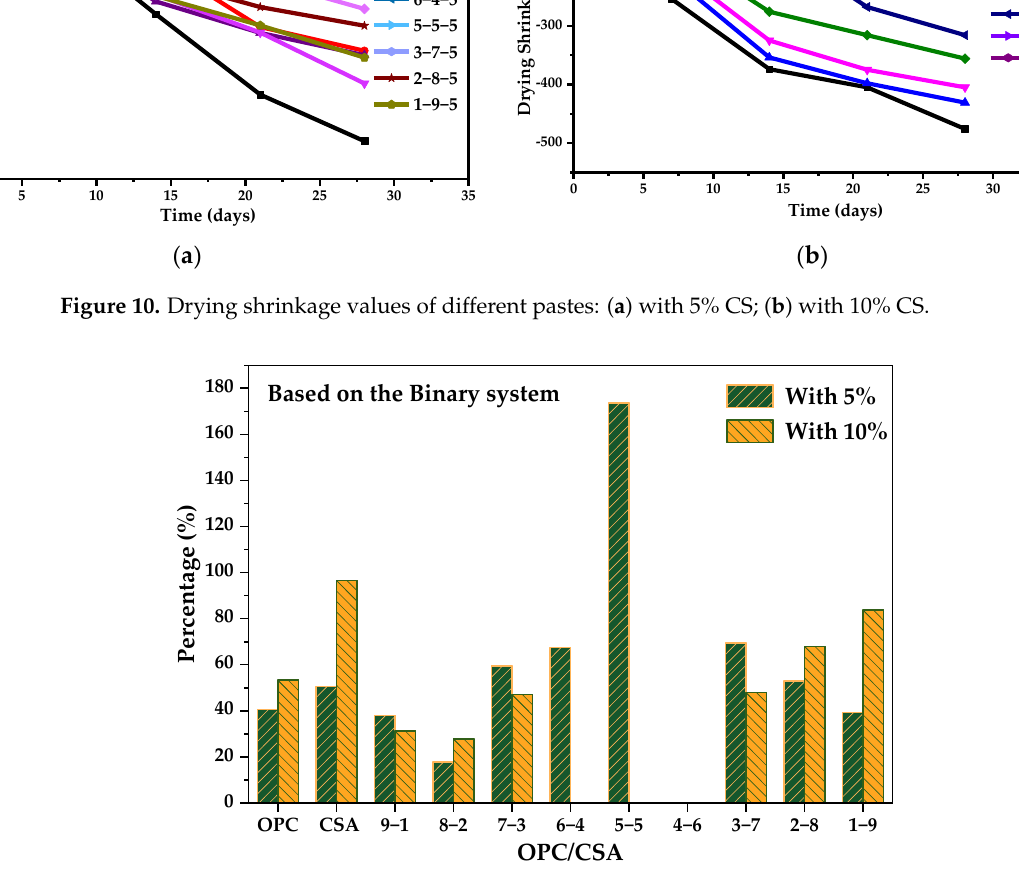
Figure 11. Effects of adding CS on the dry shrinkage of OPC-CSA binary systems.